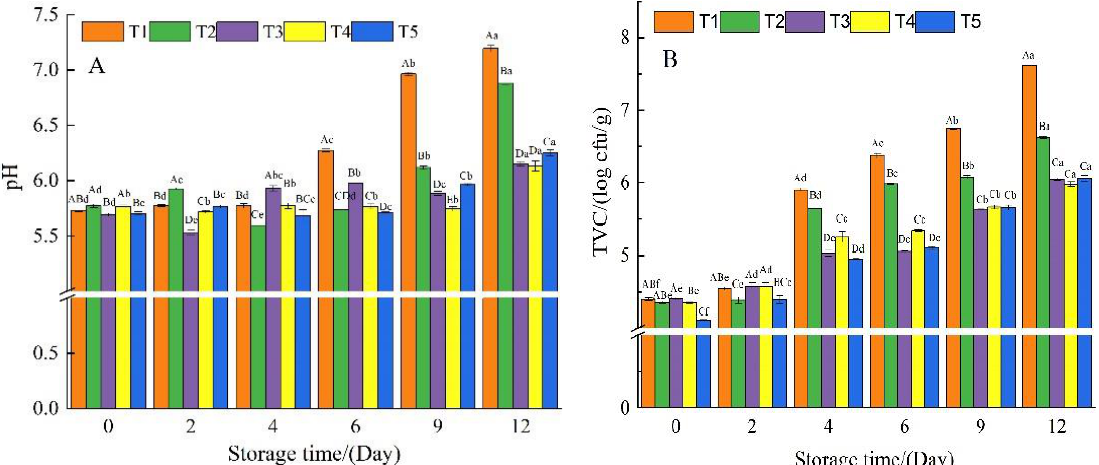
Figure 2. The pH ( A ) and total viable count ( B ) of beef samples from different treatment groups during storage. T1: Control, beef samples immersed in distilled water; T2: Beef samples treated with GEL-CHI-GLY edible coating; T3: Beef samples treated with GEL-CHI-GLY-CA edible coating; T4: Beef samples treated with GEL-CHI-GLY-GA edible coating; and T5: Beef samples treated with GEL-CHI-GLY-RES edible coating. a–e Values in the same row bearing different superscripts are different ( p < 0.05). A–E Values in the same column bearing different superscripts are different ( p <